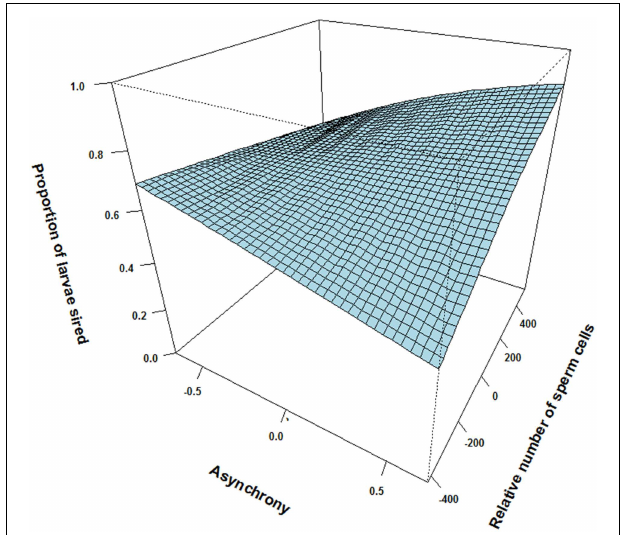
FIGURE 1 | The interactive effect of relative number of sperm cells and ejaculation asynchrony on proportion of larvae sired between pairs of males in sperm competition. An asynchrony value of—0.67 indicates that the male releases milt 0.67s before the competing male and 0.67 indicates that the male release milt 0.67s after the competing male. In our experiment dominant males either released their ejaculate before or in synchrony with the subordinate male, while subordinates either released their ejaculate in synchrony or after the dominant male. Although, a subordinate male may ejaculate later than a dominant male, he might compensate for the delay by increasing sperm numbers.